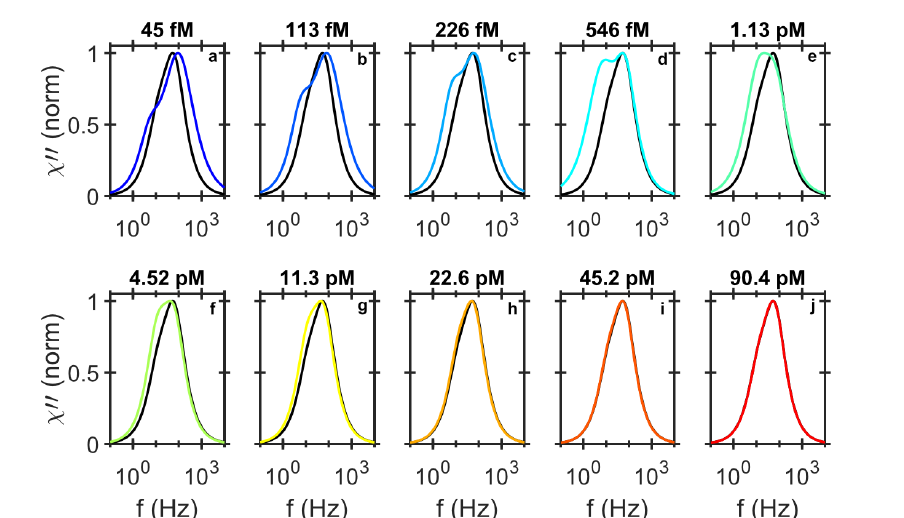
Figure 4. Normalized imaginary component of the differential ac susceptibility. To compare the shape of the imaginary component of the differential ac susceptibility from different RCP concentrations diluted in PBS ( a – j ), we normalized the fitted bi-modal model to the imaginary responses and plotted them individually with the normalized imaginary response from the NC sample (black line). The shapes of the response curves, especially at low concentration of the RCPs are very different form the NC sample. For higher concentration of RCPs, the low frequency contribution decreases and falls outside of the measurement frequency window and the shape of the response signal becomes similar to the NC sample.